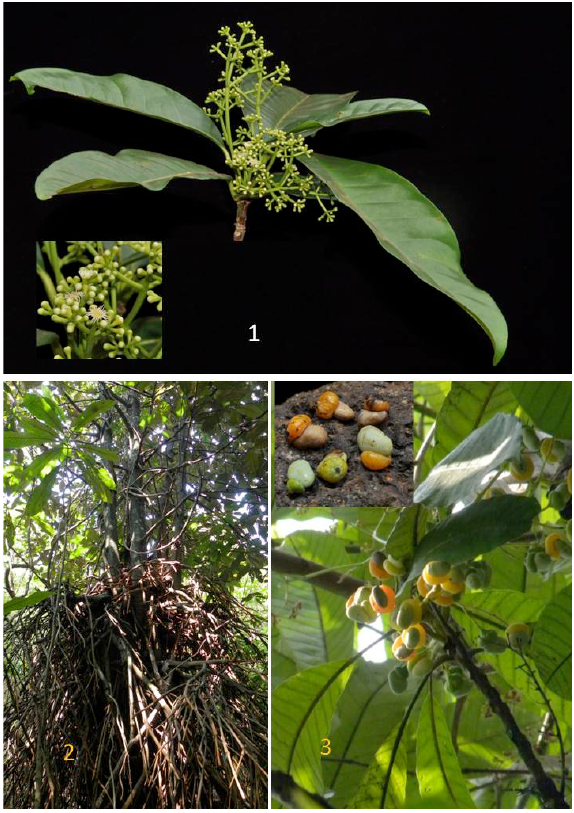
Image 1. (1) Syzygium travancoricum - Flowering twig (inset: close- up of flower); (2) Myristica fatua var. magnifica - Stilt roots; (3) Semecarpus kathalekanensis - Fruiting twig (inset: close-up of fruits). (© M.K. Janarthanam) Image 2. Herbarium of Syzygium